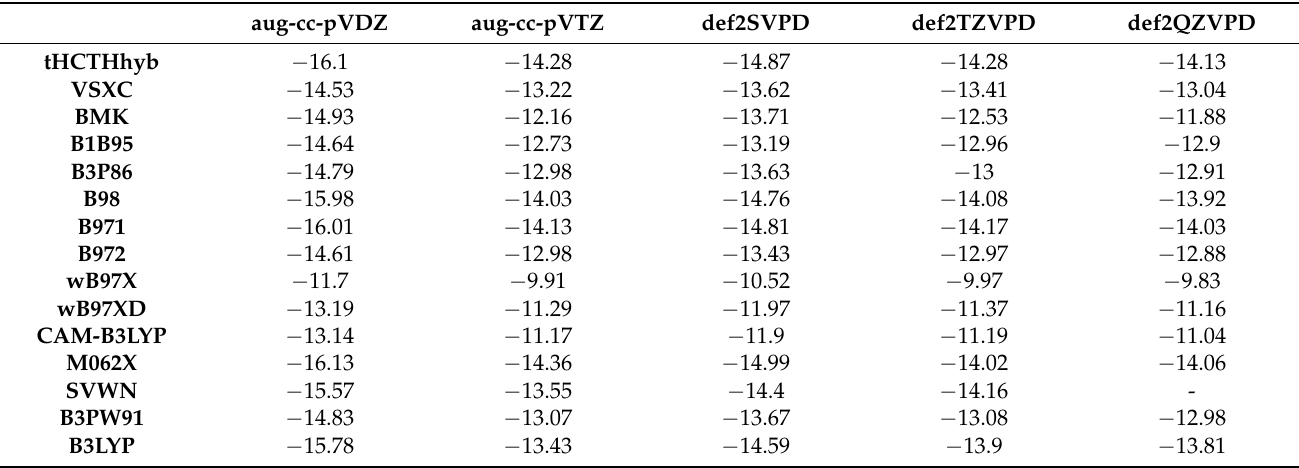
Table 1. Mean percent errors (with respect to the measured gas-phase values) of the singlet-singlet excitation energy calculations performed with various functional/basis set combinations. ∆ is defined by Equation (2). See Table S1 for ∆ st , and ∆ abs (defined by Equations (3) and (4)).